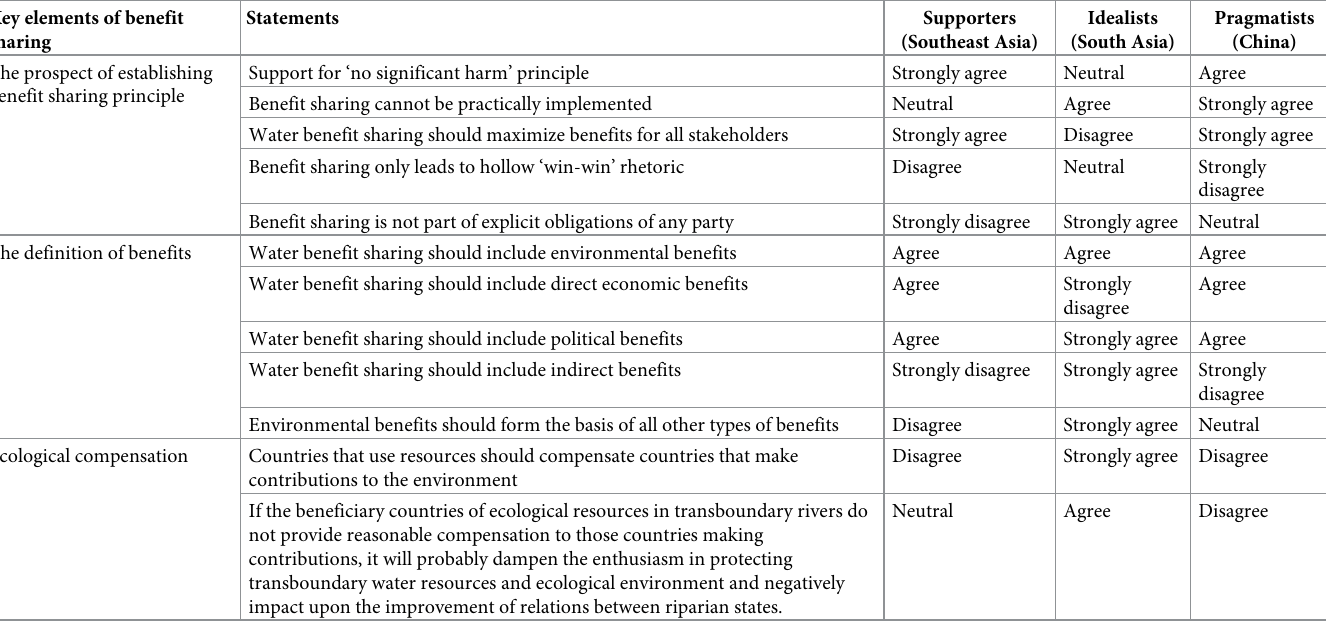
Table 3. Stances on notable issues by perspective